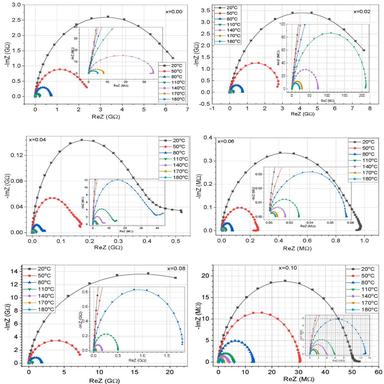
Cole-Cole impedance plots of NCZFe2-4xSn3xO4 NSFs.